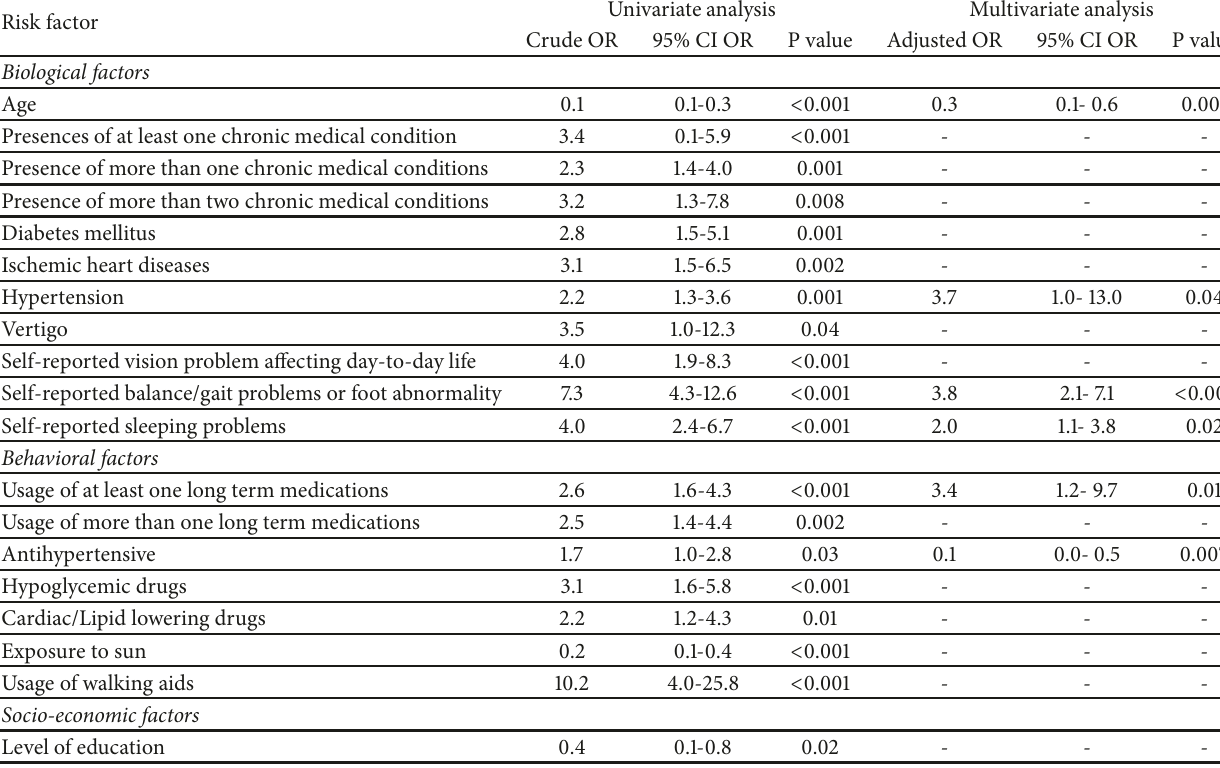
Table 6: Logistic regression analysis of risk factors for recurrent falls